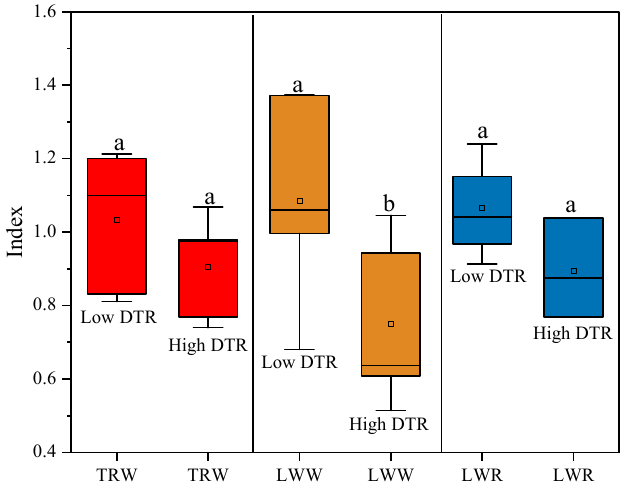
Figure 8. Comparison of tree-ring width (TRW), latewood width (LWW) and latewood ratio (LWR) under low and high DTR years. The squares and horizontal lines inside the boxplot indicate the mean and median values, and the bottom and top edges indicate the 25th and 75th percentiles. a, b—different letters indicate significant differences (Tukey test). Moving correlation analysis with the 21-year window revealed that the influence of temperature on the different indices of chronology was unstable and indicated index dif- ference. The negative effect of temperature and the DTR declined for TRW and LWW but not for LWR. Whereas the positive effect of precipitation was strengthened only for LWR, it seemed static for LWW and decreased for TRW (Figure 9).